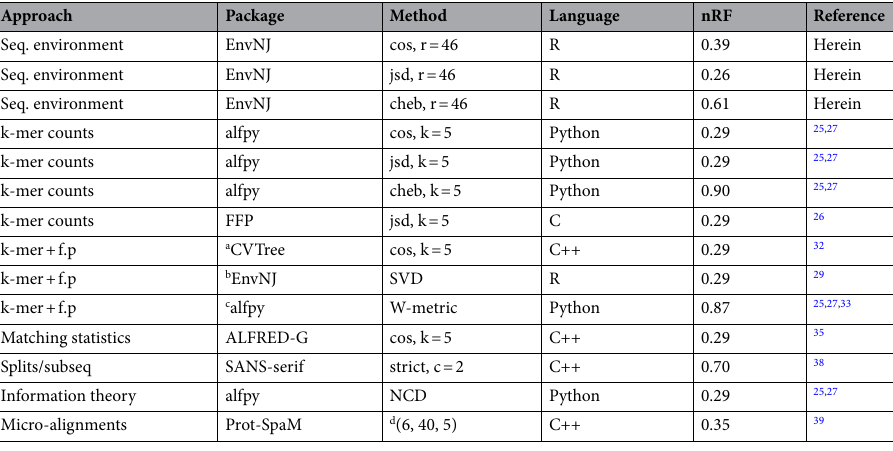
Table 2. Normalized Robison-Foulds distances between trees obtained using different alignment-independent methods with respect to the refence tree shown in Fig. 3B. The whole protein-coding mitogenomes of a group of 34 mammalian species were analyzed. For details regarding the input parameters used for each method, please consult the given reference. Briefly, cos, jsd and cheb stand for cosine, Jensen-Shannon and Chebyshev metrics, respectively. The abbreviation f.p. stands for ‘further proccessing’. Thus (a) filters considering background words frequencies; (b) uses singular value decomposition, SVD, to analyze the 4-mer frequency data; (c) the matrix used for the W-metric analysis was Blosum62. (d) The parameters for the use of Prot-SpaM were weight of w = 6, with d = 40 (don’t-care positions) and m = 5 patterns. The parameter filter of SANS-serif was set to ‘strict’. NCD is the acronym of normalized compression distance.